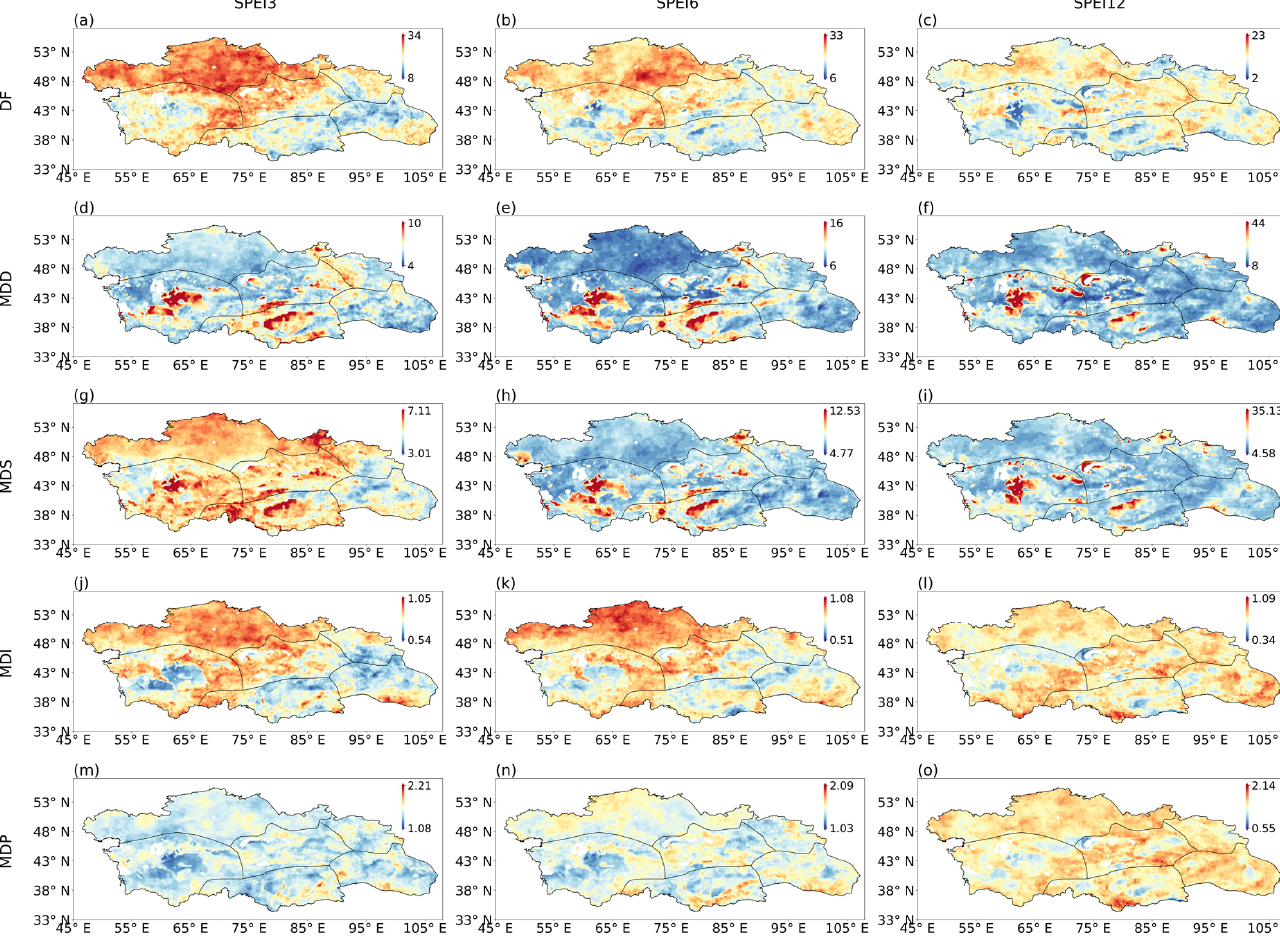
Figure 6. Spatial patterns of drought characteristics for SPEI3, SPEI6, and SPEI12. Subplots ( a – o ) represent drought characteristics at different scales (SPEI3, SPEI6, and SPEI12).